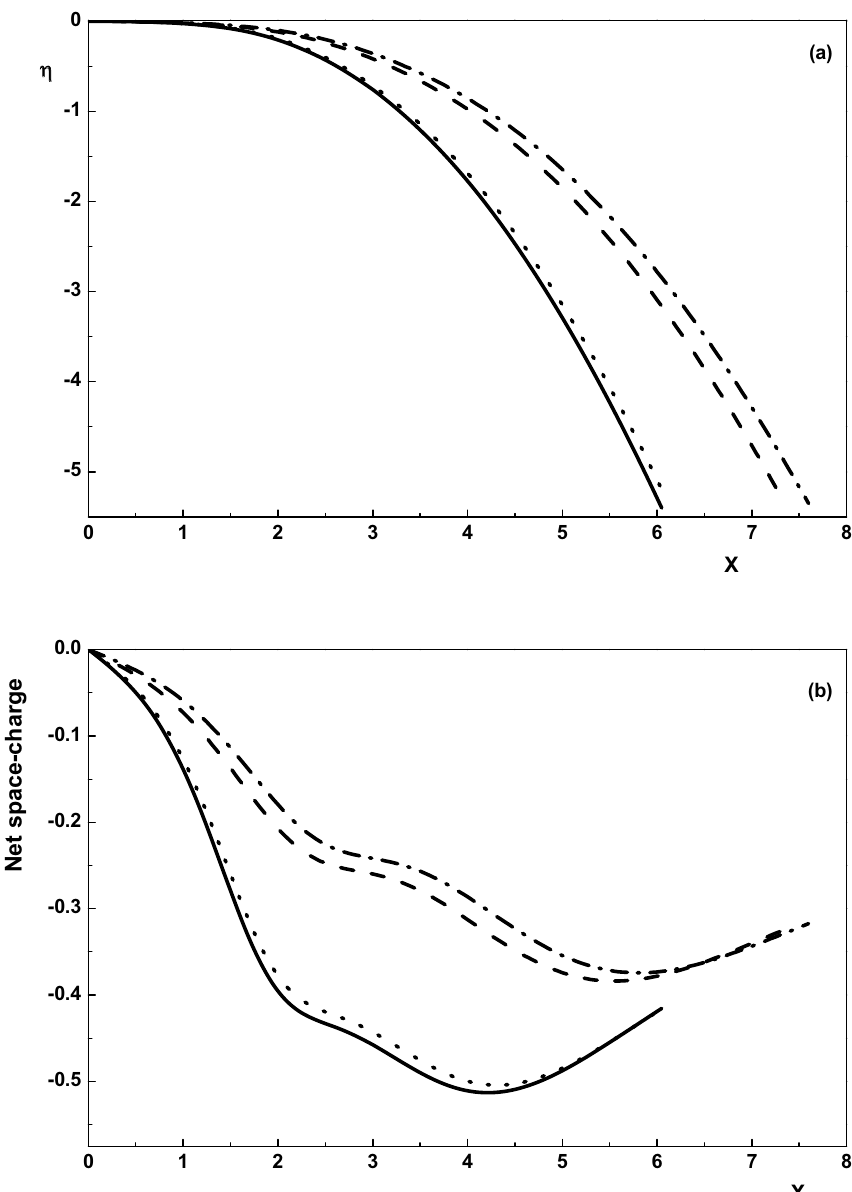
Figure 6. Variation of the normalized ( a ) electric potential and ( b ) net space-charge toward the wall for ν p 1 = 0, u 01 x = 0.720, α = 0.01 (dotted line), ν p 1 = 0, u 01 x = 0.933, α = 0.02 (dotted-dashed line),